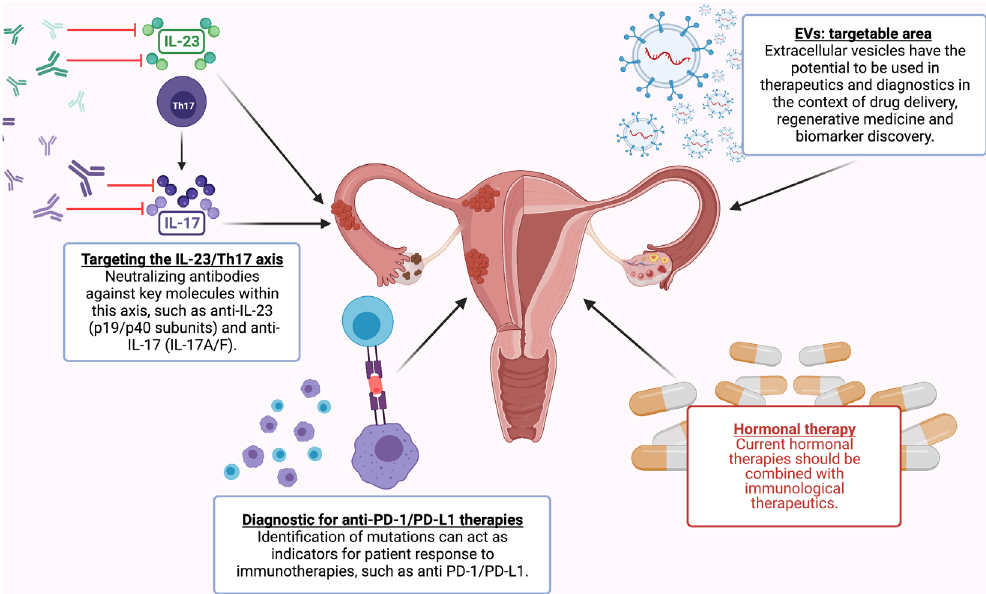
Figure 3. Summarizing our perspectives on EMS therapeutic